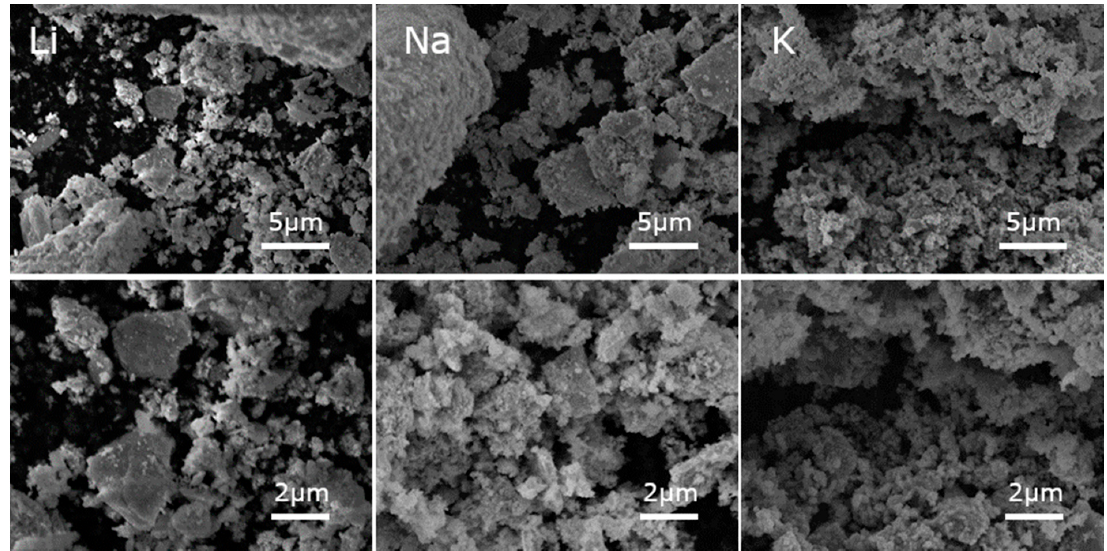
Figure 2. SEM micrographs of La 0.9 A 0.1 MnO 3 (A: Li— left , Na— center , K— right ) powders.